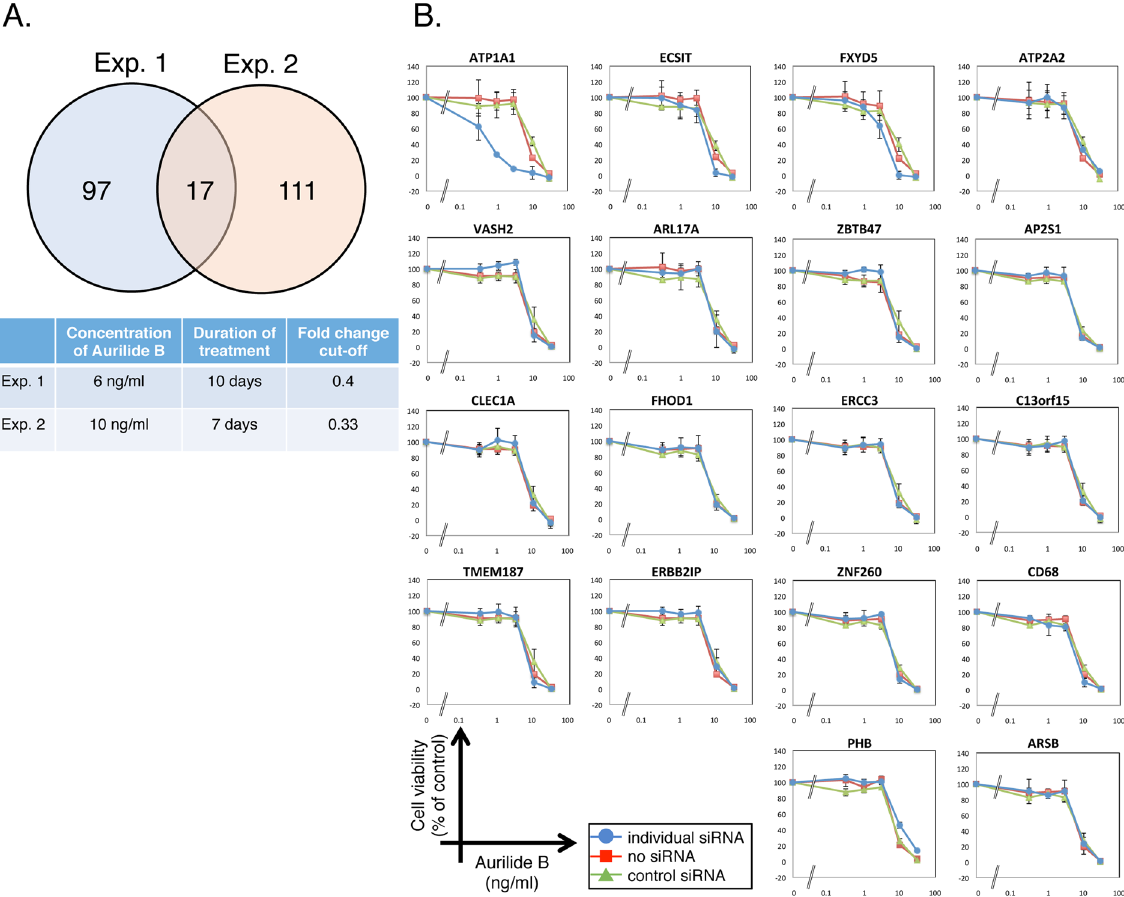
Figure 3. Candidate genes that determine the sensitivity to aurilide B. ( A ) shRNA screening for genes that modify the sensitivity to aurilide B was performed in HeLa S3 cells under two independent conditions. Seventeen genes whose knockdown sensitized cells to aurilide B were identified in both experiments ( P = 4.07 × 10 − 15 , Fisher’s exact test, R version 3.3.2). ( B ) HeLa S3 cells were transfected with siRNA pools against 17 candidate genes, and then cultured for 2 days in the presence of the indicated concentrations of aurilide B. Cell viability was measured by WST-8 assay. Data represent means ± SD from three independent